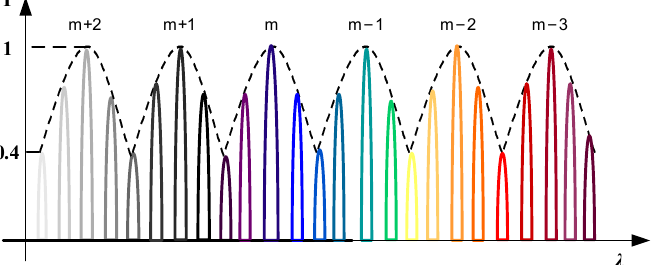
Figure 4. The diffraction efficiency schematic of the echelle in a broadband spectral range.